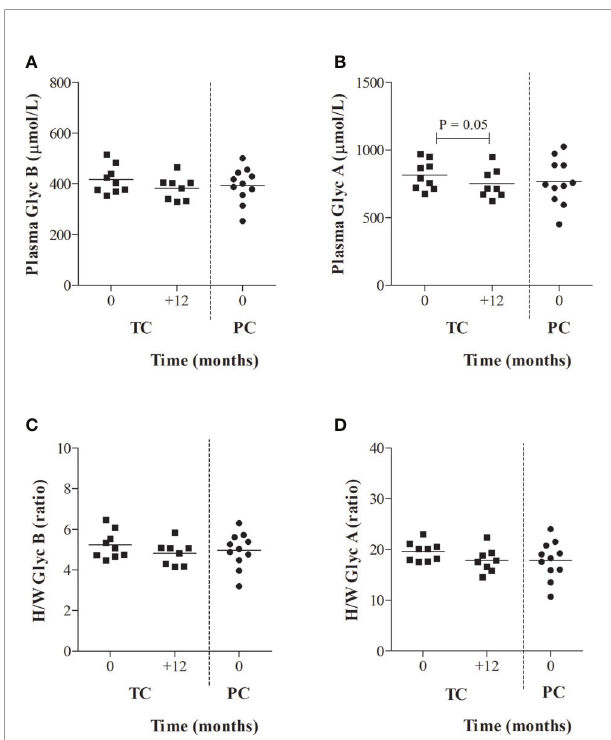
FIGURE 3 | Serum glycoprotein evolution in TCs compared to PCs. (A) Serum glycoprotein B and (B) glycoprotein A concentrations and height/ width ratios for (C) glycoprotein A and (D) glycoprotein B are represented for transient controllers (TCs) during their follow-up. Values from PCs obtained in Figure 2 at T0 were also included as reference values for TCs. Data were compared using the Wilcoxon ’ s non-parametric test for paired